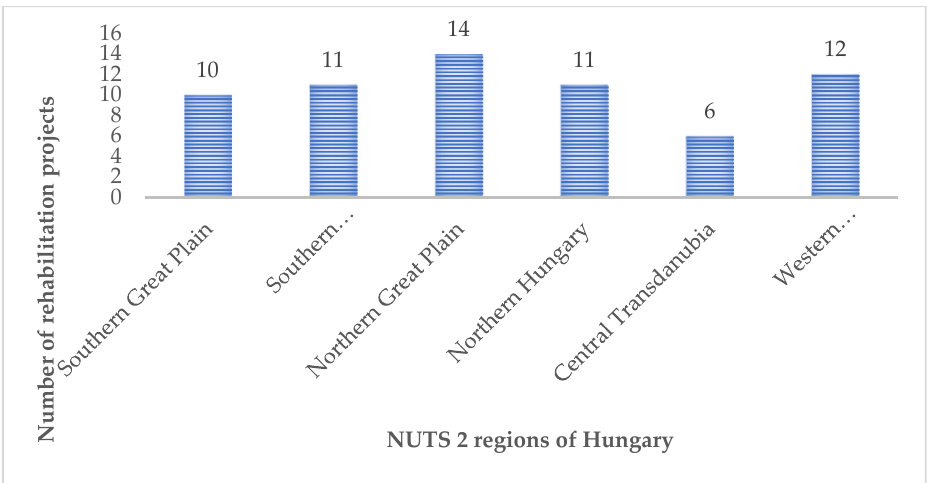
Figure 2. Total number of brownfield rehabilitation projects on NUTS 2 level (N = 64).